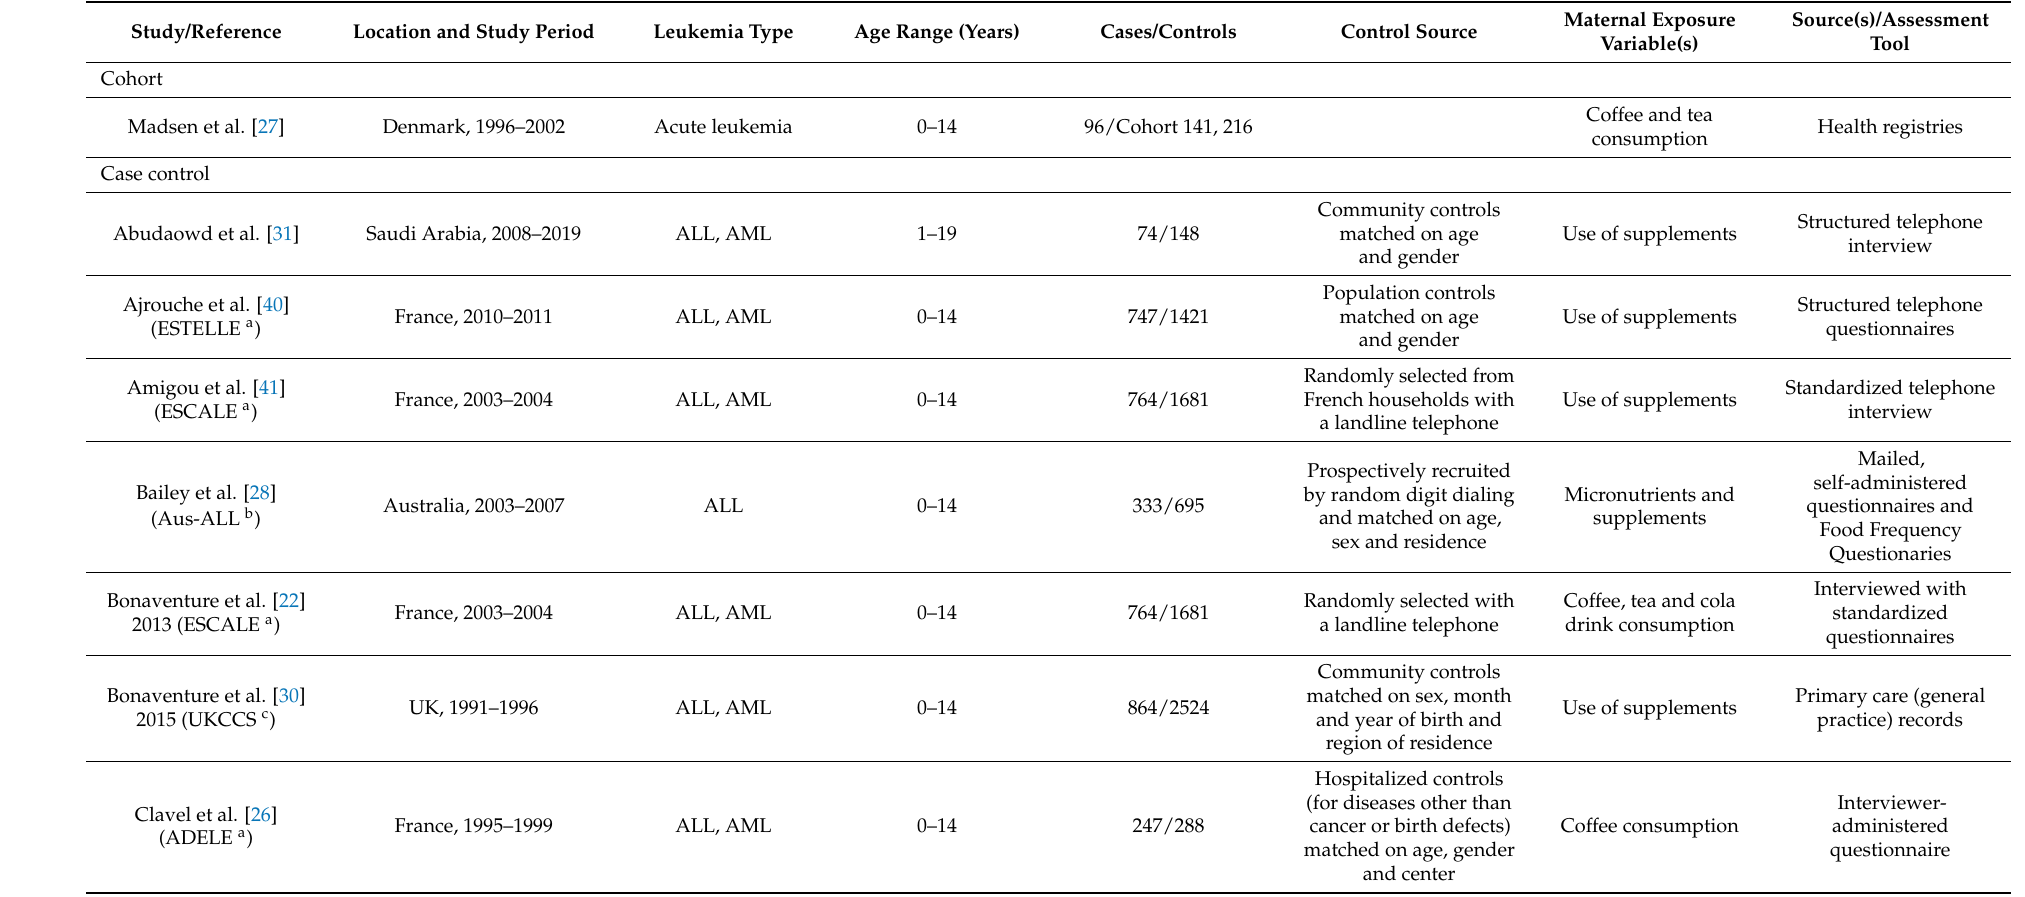
Table 4. Characteristics of the included